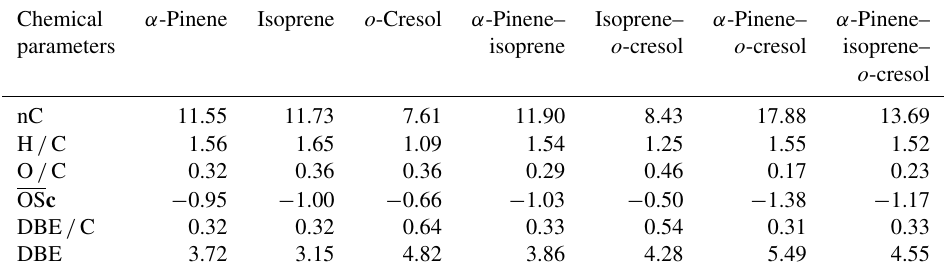
Fig. 6. In all mixed systems, the five compounds with the highest signal fraction that were also present in each corre- sponding single precursor system are shown alongside the top five compounds uniquely found in the mixture but absent from any single precursor system. Only compounds found in all repeat experiments in each system were chosen for this analysis, so there is confidence in the component identification. (a) The binary α -pinene–isoprene system The components in the binary mixture system that were also found in the single precursor α -pinene system were found to have a larger signal fraction than those found in the sin- gle isoprene system and the unique compounds. In particu- lar, it was found that C 9 H 14 O 4 made the greatest signal con- tribution (Fig. 6a). This is also the case in the single pre- cursor α -pinene system, and it is likely to be pinic acid due to this peak having a similar fragmentation pattern (Figure S3) compared to results reported in Yasmeen et al. (2010). tion in the binary mixture system, with a normalized molec- ular abundance of 4.4 % and 3.4 %, and were also found to be conserved in both single precursor systems. Compounds that were only present in the binary mixture had relatively low abundance, with the highest contribution from C 17 H 14 N 2 O 17 with only 0.7 % of the total signal fraction. Clearly, the SOA particle composition in the binary α -pinene–isoprene system was dominated by α -pinene components and partially con- tributed by isoprene, but not those from cross-products from their interaction. (b) Binary α -pinene– o -cresol system As shown in Fig. 6b, the four most abundant peaks (three C 7 H 7 NO 4 isomers (i to iii) and C 7 H 7 NO 3 ) in the mixture were found to be present in the single precursor o -cresol system. C 7 H 7 NO 4 isomers in the binary mixture had signal contributions of 51.7 % (iii), 8.6 % (ii), and 2.5 % (i), with in both the single VOC α -pinene system and mixed